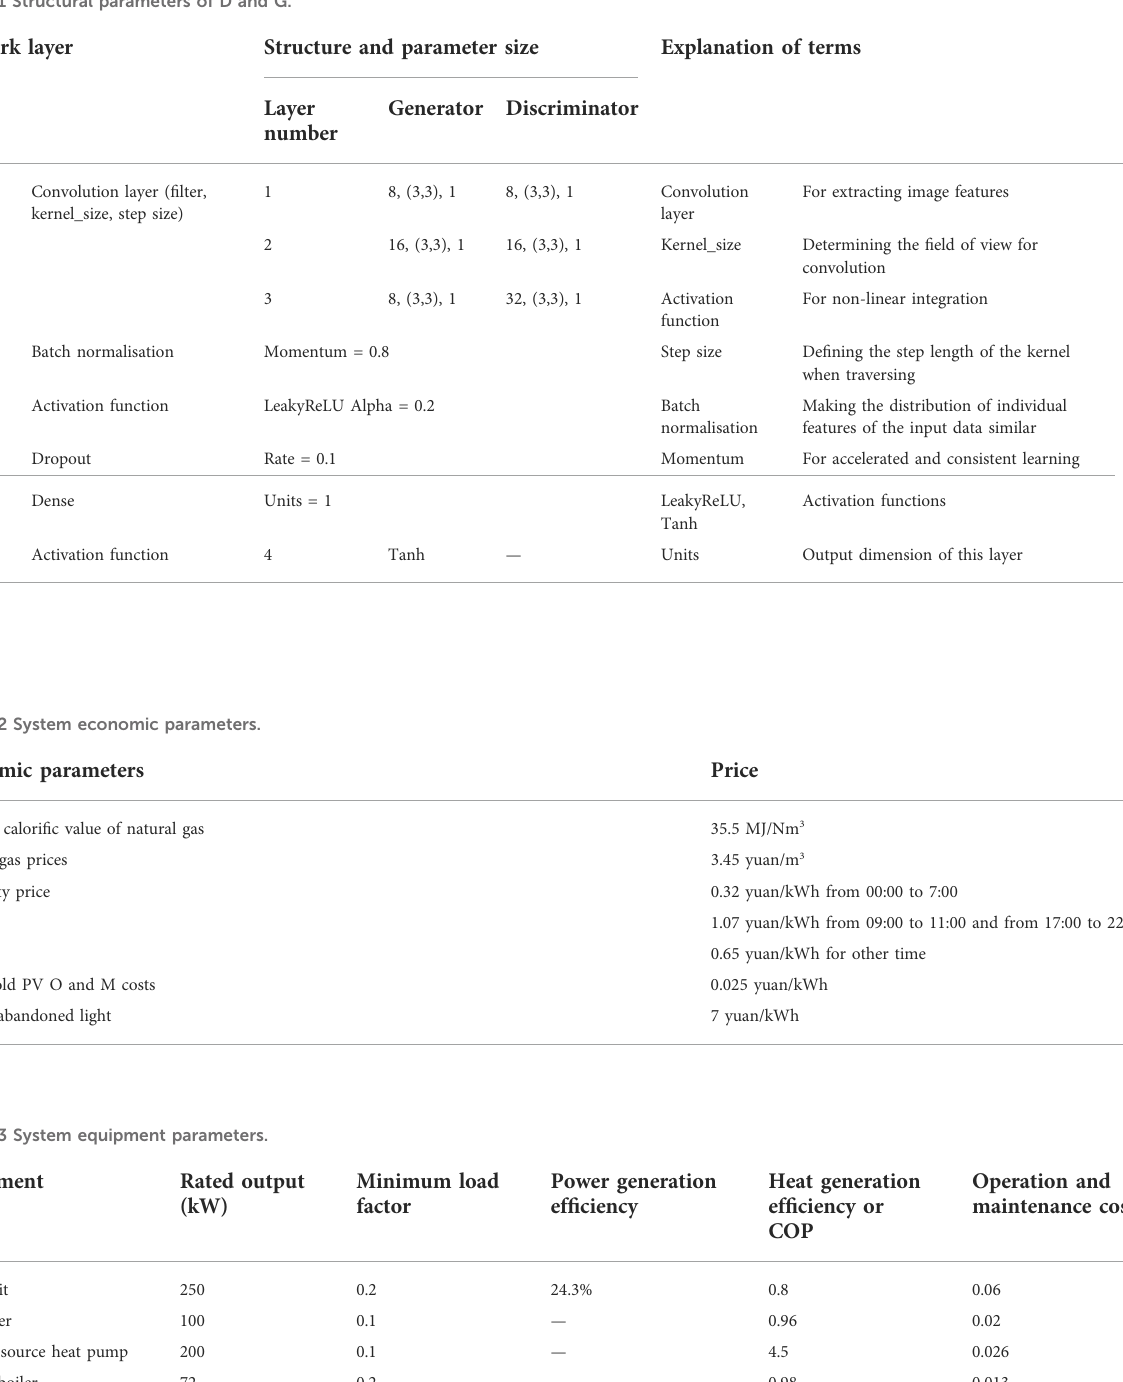
different degree of decrease in MAPE. The MAPE A is 3.87%, which is further reduced compared to the MAPE A in the day- ahead stage of 5.08%.